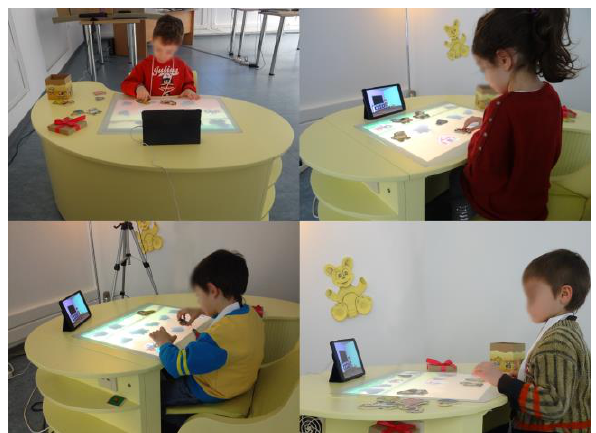
Figure 9. Young children participating in the evaluation